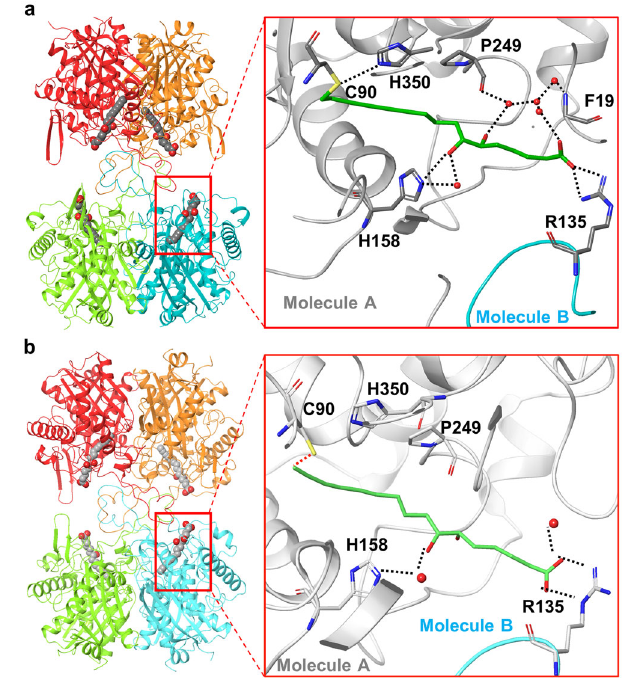
Fig. 5 X-ray structures and polar interaction within the binding site of MasL-collimonin C and MasL-collimonin D complex. Overall views of the crystal structures of MasL-collimonin C complex ( a ) and MasL-collimonin D ( b ). Four subunits per asymmetric cell are shown in red, orange, light green, and cyan, respectively. Collimonin C/D 1 , 2 is shown as grey space- fi lling balls. In the magni fi ed view, the residues involved in collimonin C/D 1 , 2 interactions are shown as sticks with sequence identities indicated in the main chain molecule shown in gray. The R135 residue of another molecule is shown in cyan. The dotted lines indicate the hydrogen bonds and salt bridges involved in collimonin C/D 1 , 2 interactions within the binding